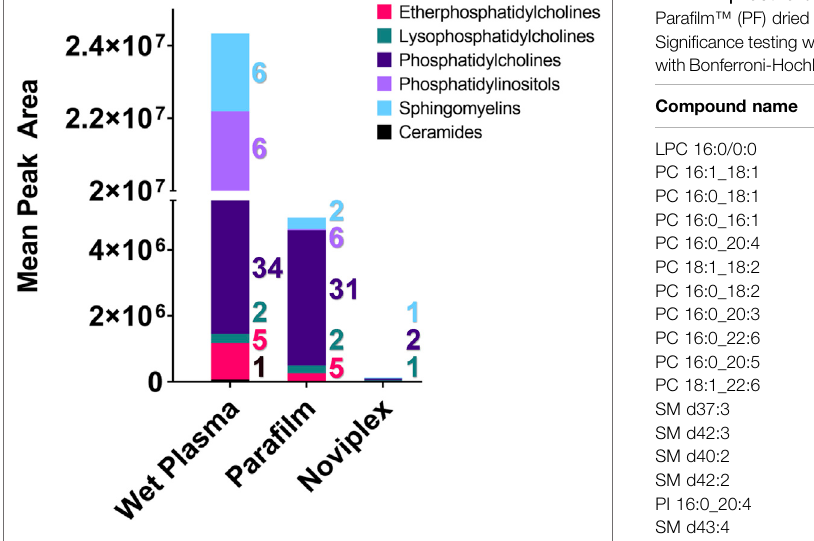
FIGURE 6 | The summed average area of chromatographic peaks (Gaussian smoothed) for different lipid classes identi fi ed within each Sample processing method (WP, PF, & NP). Each coloured segment of the stacked bar graph represents the mean chromatographic area for the respective lipid class. The colour coded numbers to the right of each bar represent the number of lipids that were detected in each category. Abbreviation: Cer, Ceramide; EPC, Ether Phosphatidylcholine; LPC, Lysophosphatidylcholine; PC, Phosphatidylcholine; PI, Phosphatidylinositol; SM, Sphingomyelin.